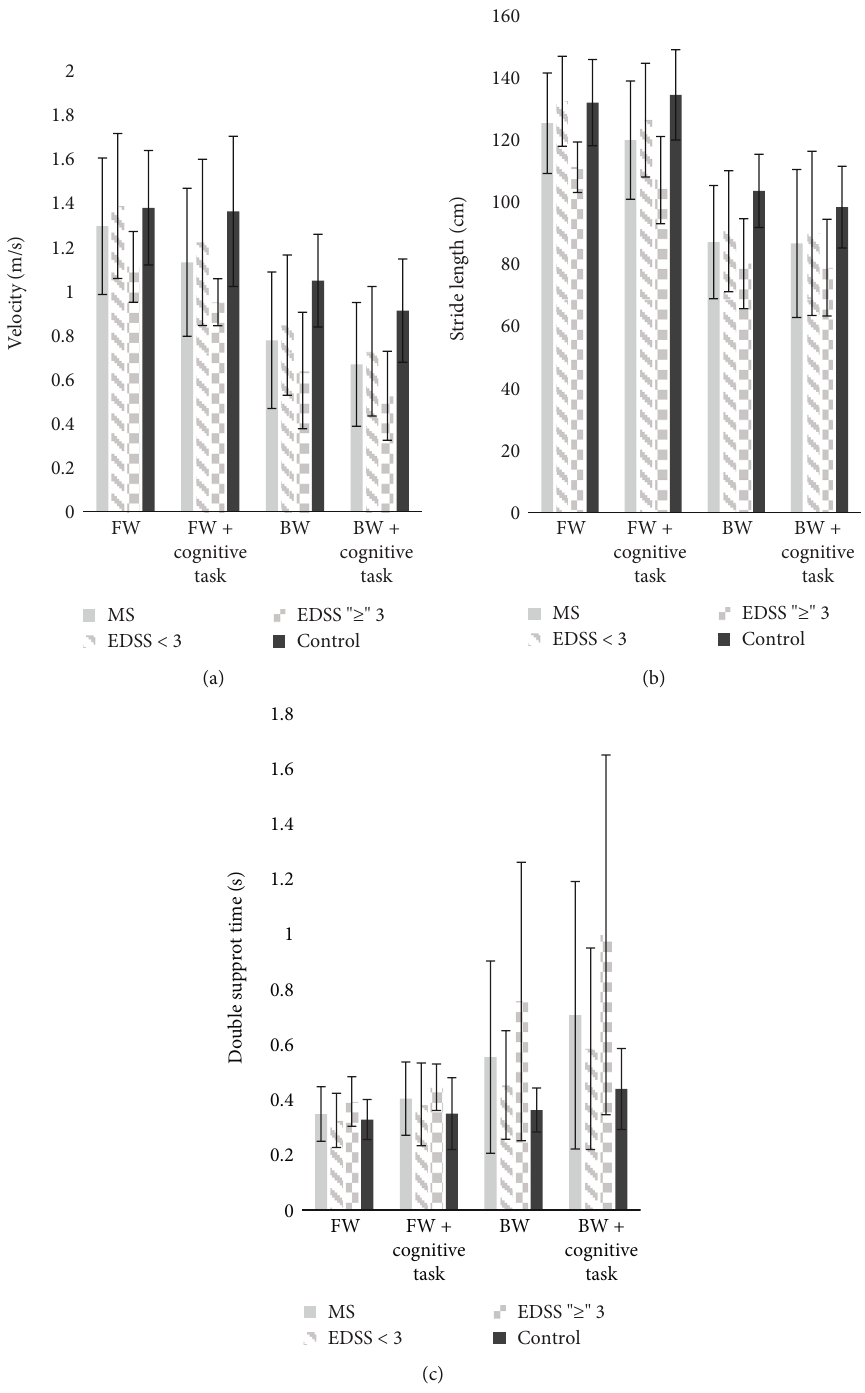
Figure 2: Subanalysis to examine di ff erences in walking performance among individuals with EDSS < 3 and those with EDSS ≥ 3 . MS is marked by the grey bar and HC by the black bar, with individuals with low disability ( EDSS < 3 ) marked with diagonal lines and individuals with high disability ( EDSS ≥ 3 ) marked with checkered blocks. Individuals with lower disability ( EDSS < 3 ) performed similarly to healthy controls under single-task forward walking conditions but had worse performance than healthy controls in backward and dual-task conditions, particularly in backward dual-task